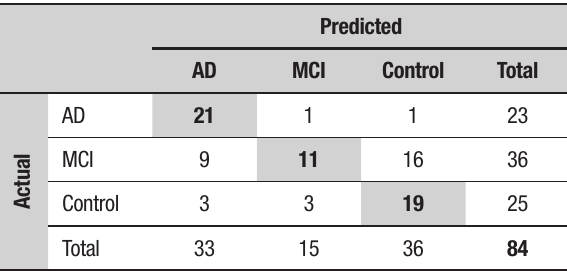
Table 5. Confusion matrix for MMSE.